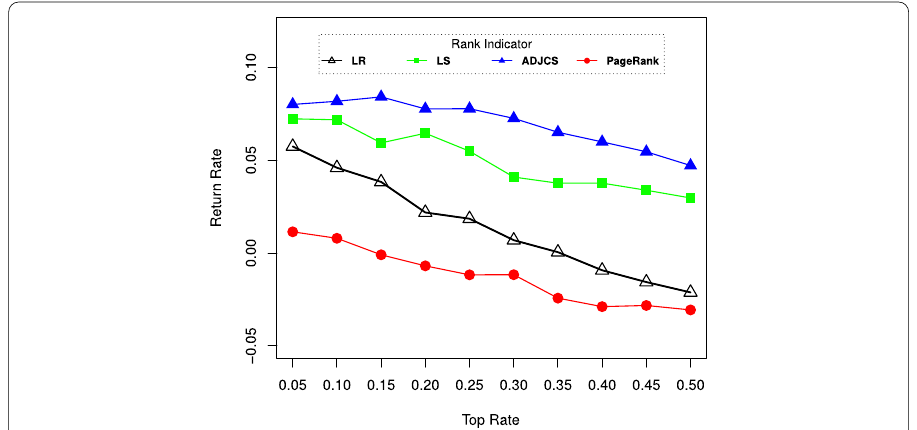
Fig. 9 Rate of return comparison of different indicators